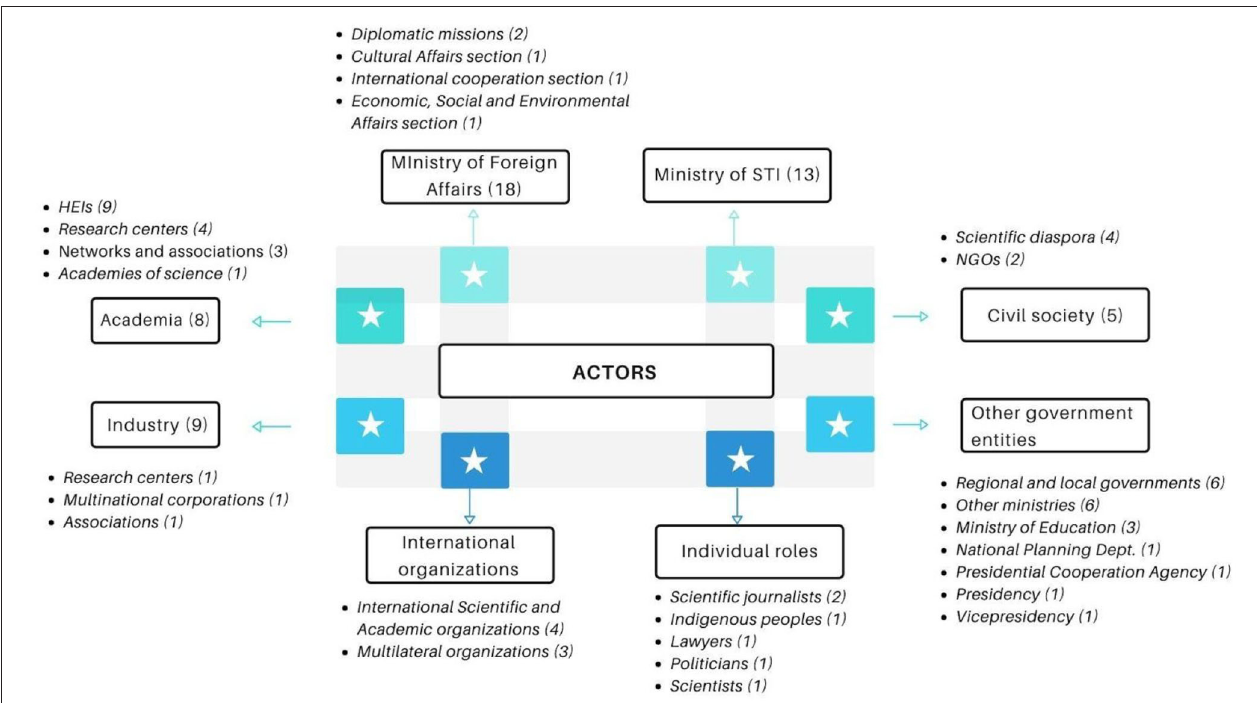
FIGURE 1 | SD Actors in Colombia. Participants were asked to indicate the actors that should be considered within a SD strategy in Colombia. Categories are developed by the authors based on the type of actors (public, private, type of organization), as well as on frequency and similarity between the answers collected.